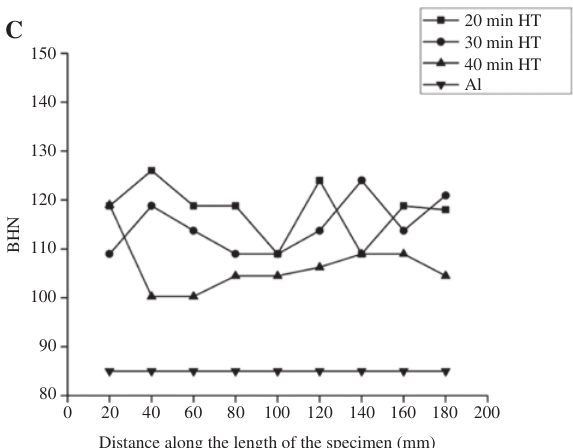
Figure 11: Influence of HT on hardness of Al/TiB